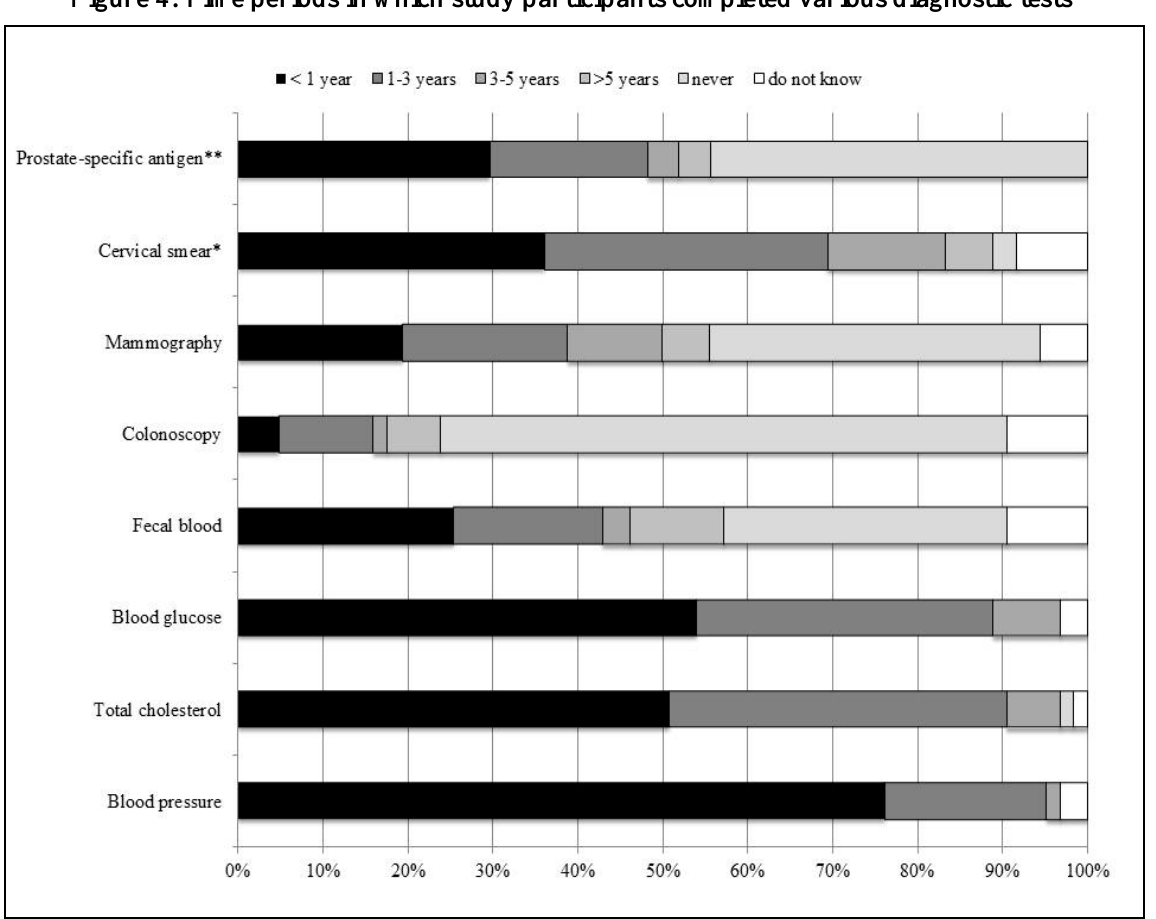
Figure 4. Time periods in which study participants completed various diagnostic tests